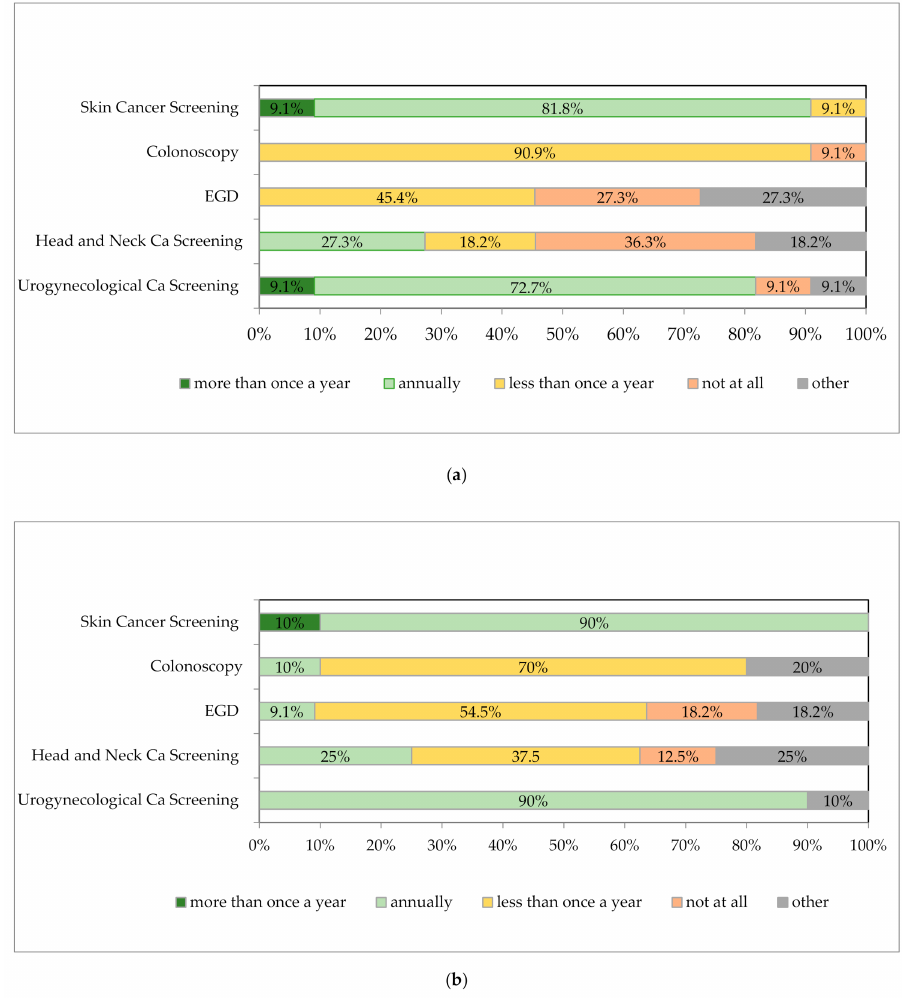
Figure 2. Follow-up procedure at German liver transplantation (LT) centers. ( a ) Cancer screening at current state ( n = 11). ( b ) Cancer screening at target state ( n = 10). Abbreviations: EGD = esophagogastroduodenoscopy, Ca =